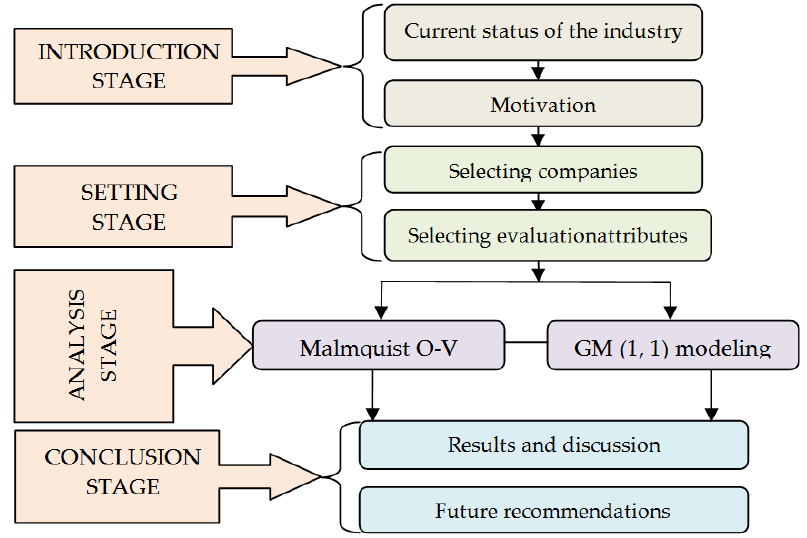
Figure 1. Research process.